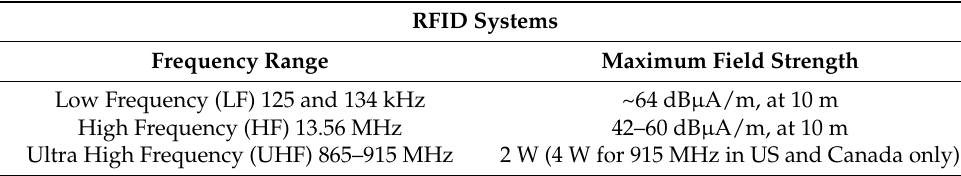
Table 2. Maximum field strengths/transmission powers allowed for RFID